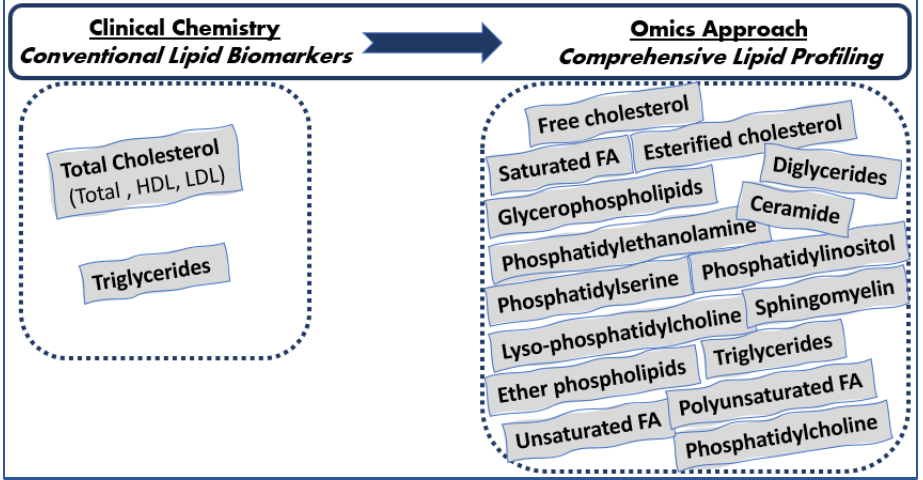
Figure 1. Lipids determined in everyday clinical laboratories vs. lipids determined with the lipidomics approach.